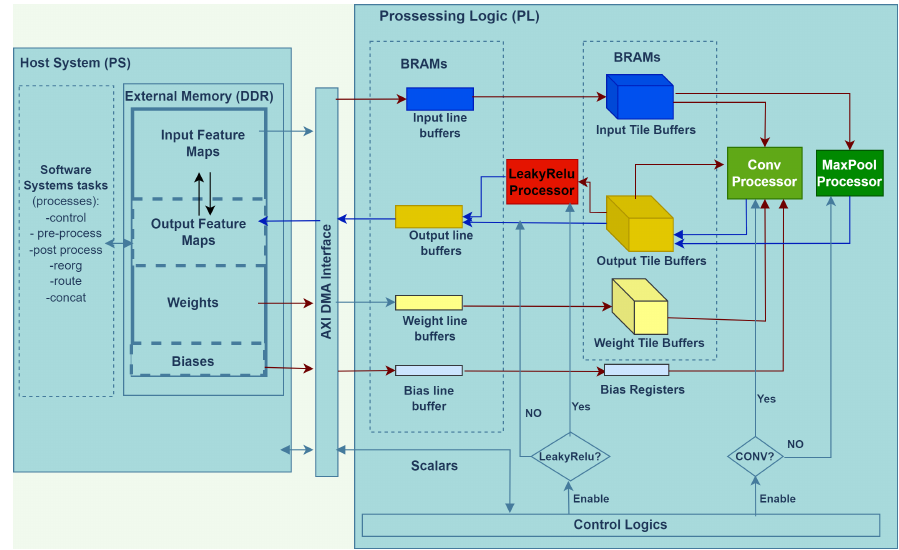
Figure 5. Overall architecture of the proposed HW/SW co-design of the inference acceleration